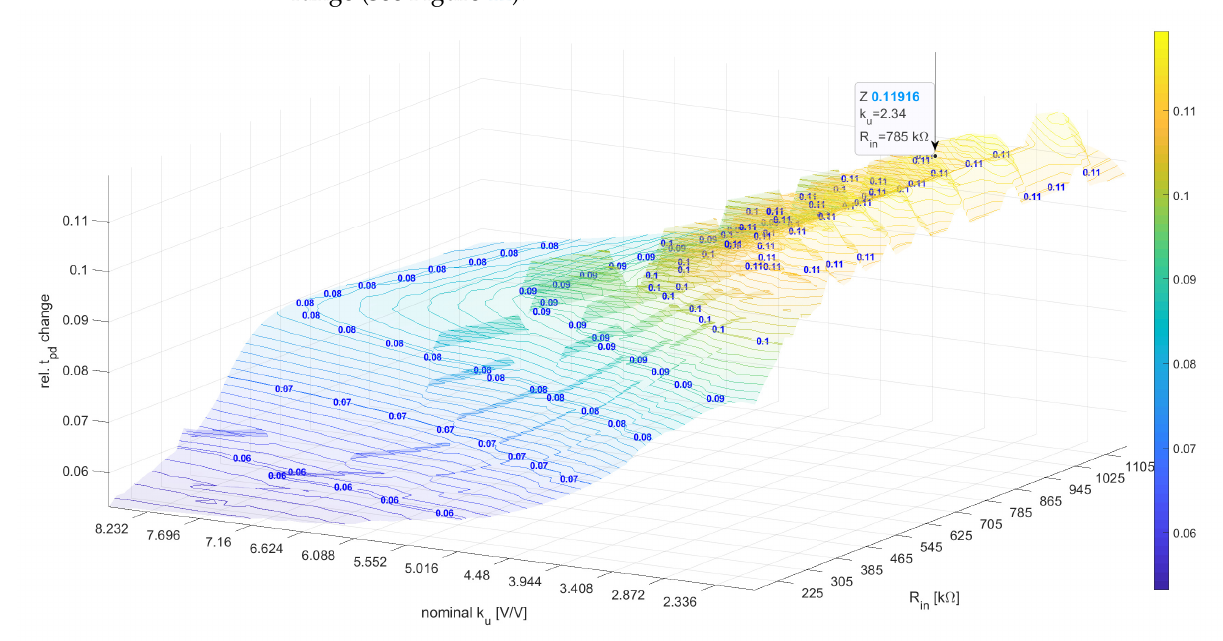
Figure 12. The relative t pd influence for various k u and R in for a nonlinear